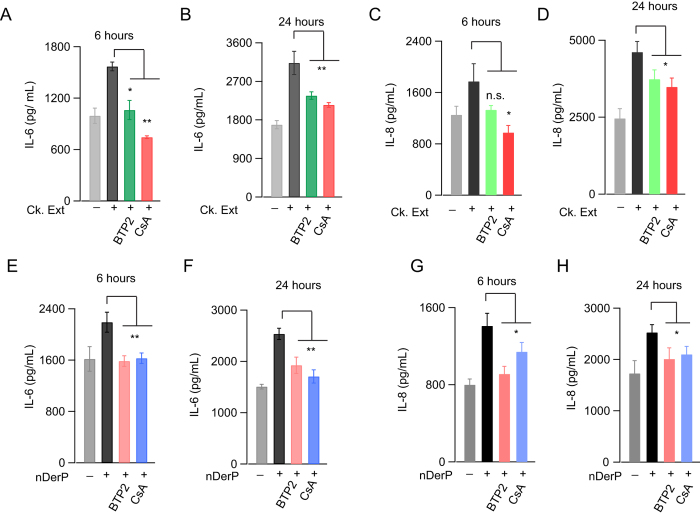
Cockroach and dust mite allergens induce IL-6 and IL-8 in a CRAC channel dependent manner.(A–H) BEAS-2B cells were treated with cockroach (10 μg/mL) or and dust mite (18 μg/mL) allergen extracts for 6 or 24 hours. Cells were pre-treated with the CRAC channel inhibitor, BTP2 (500 nM) or the calcineurin inhibitor cyclosporine A (CsA, 500 nM) for 45 minutes before allergen treatment. After allergen treatment, cell culture supernatants were collected and examined for IL-6 and IL-8 using ELISA. Mean ± SEM of 2–3 experiments with three replicates for each expeirment. *P < 0.05, **P < 0.01.